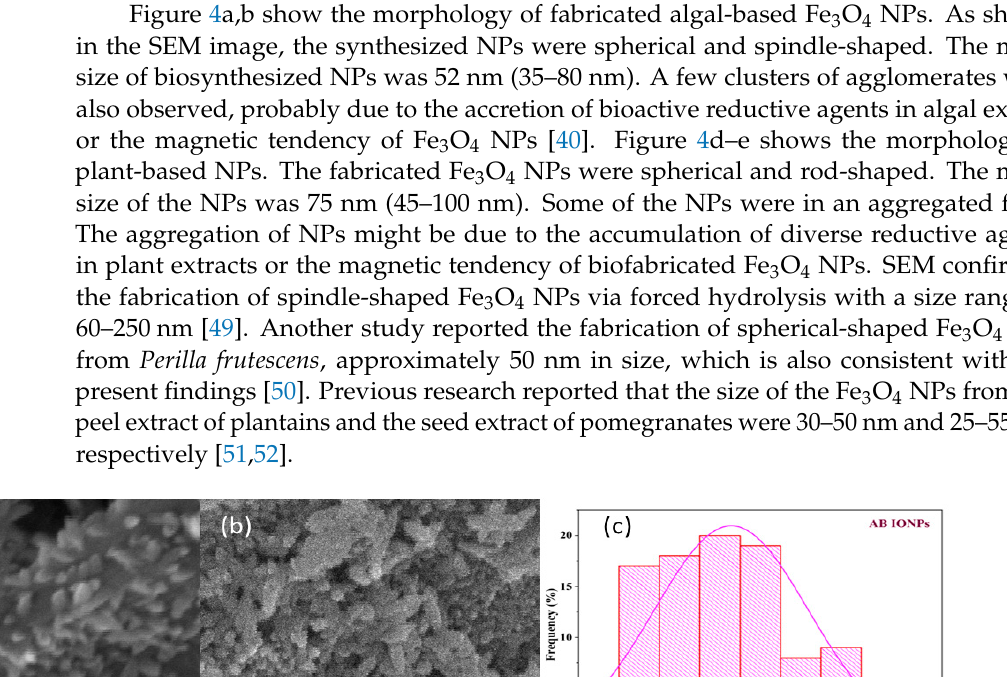
Figure 3. ( a ) XRD pa tt ern of algal-based Fe 3 O 4 NPs ( b ) XRD pa tt ern of plant-based Fe 3 O 4 NPs.